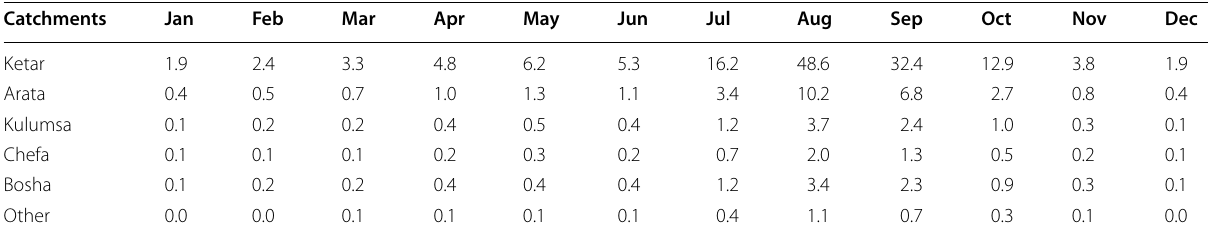
Table 3 Sub-catchments monthly average flow (m 3